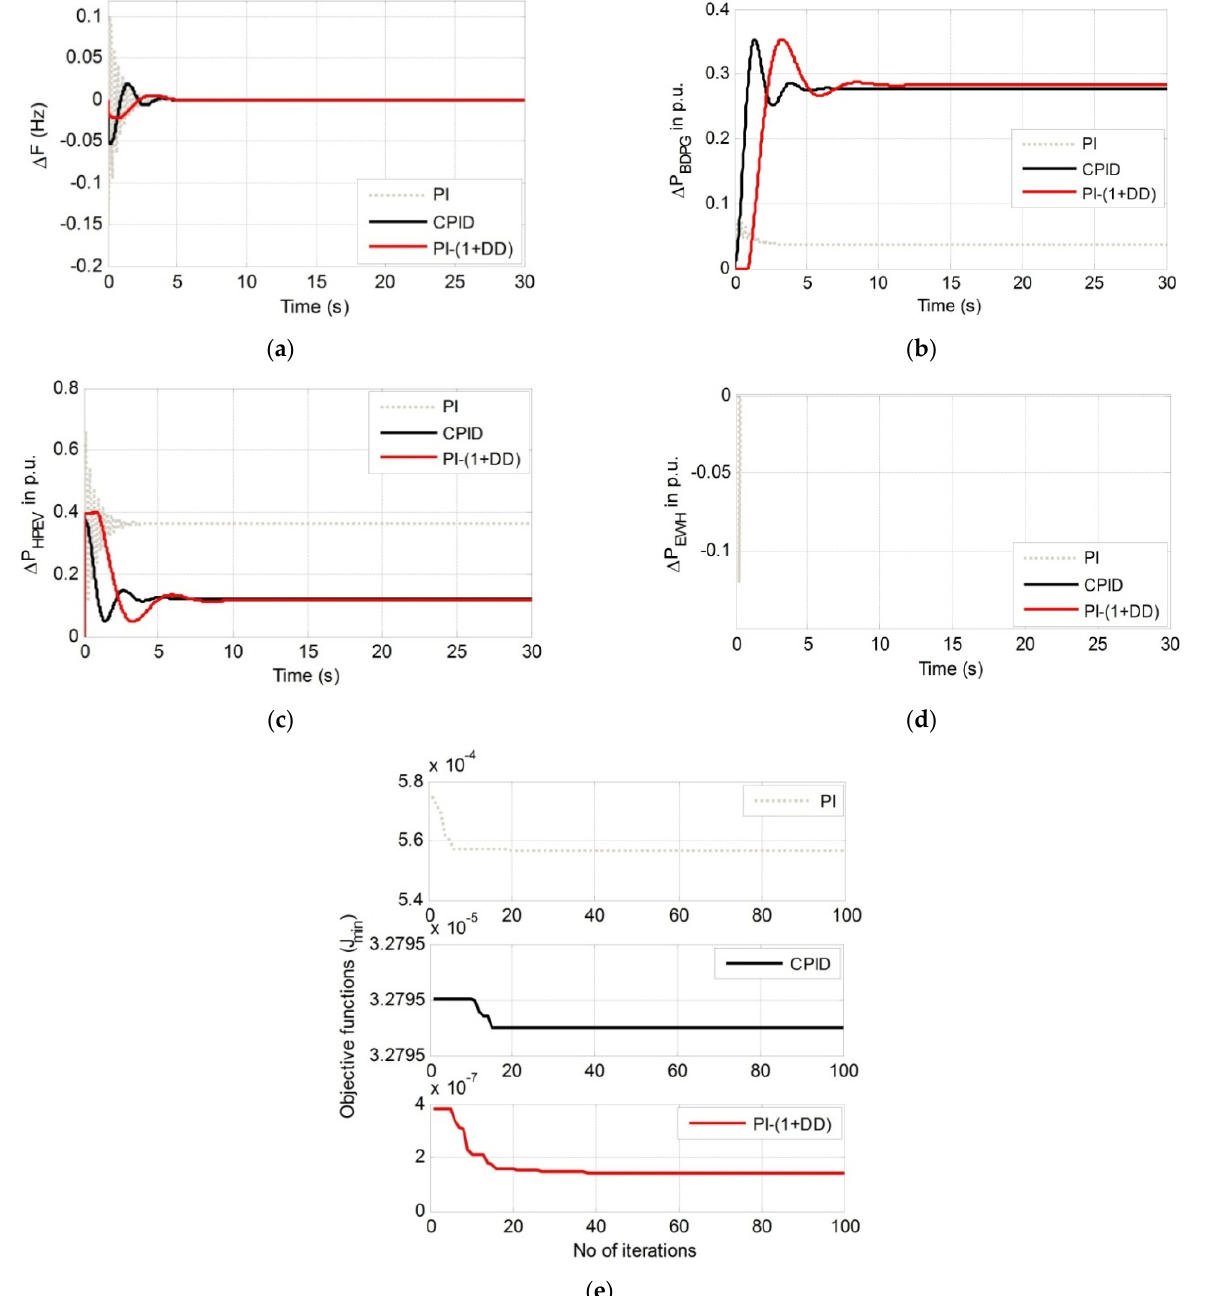
Figure 5. Comparison of the dynamic response of PI, CPID with the proposed ( a ) frequency deviation ( Δ F ), ( b ) power sharing of BDPG, ( c ) power sharing of HPEV, ( d ) power sharing of EWH and ( e ) objective functions (J).